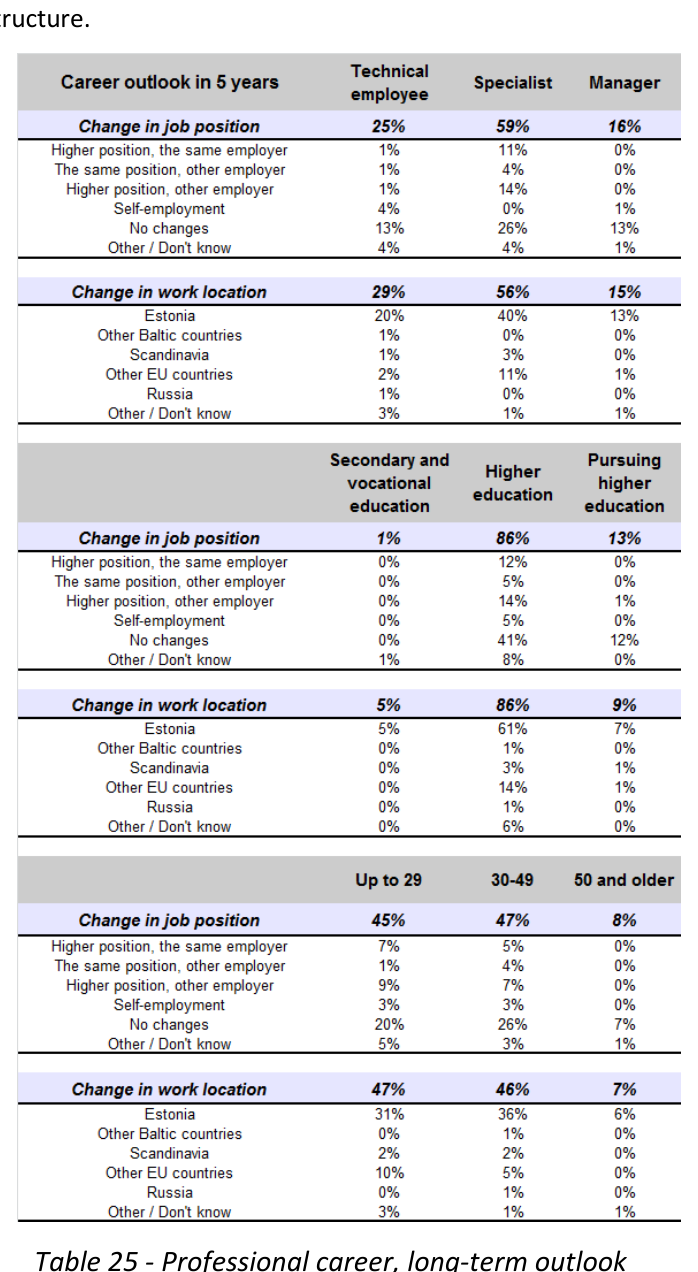
Table 25 - Professional career, long-term